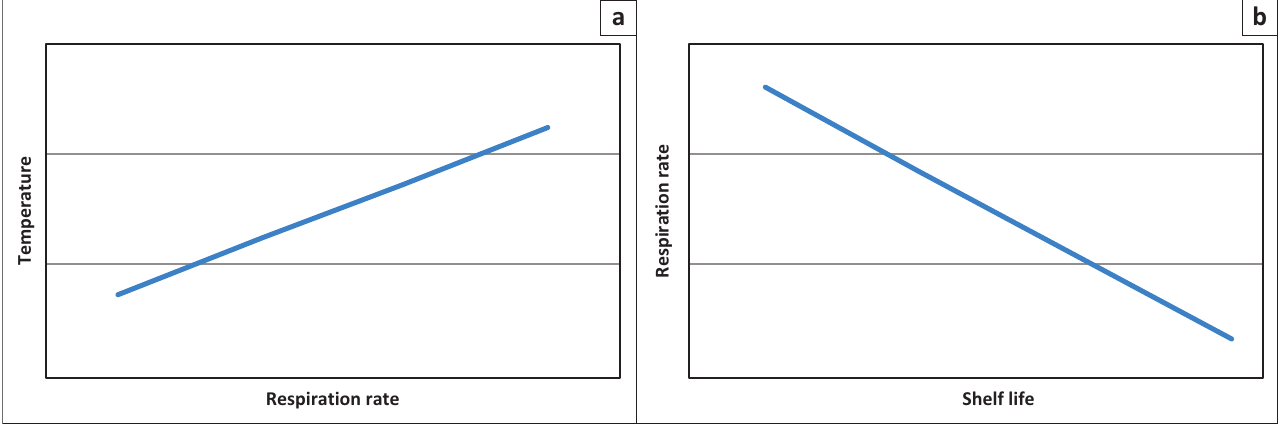
FIGURE 1: Relationship of respiration rate with that of temperature and shelf life. (a) Effect of temperature on respiration rate and (b) effect of respiration rate on shelf life.